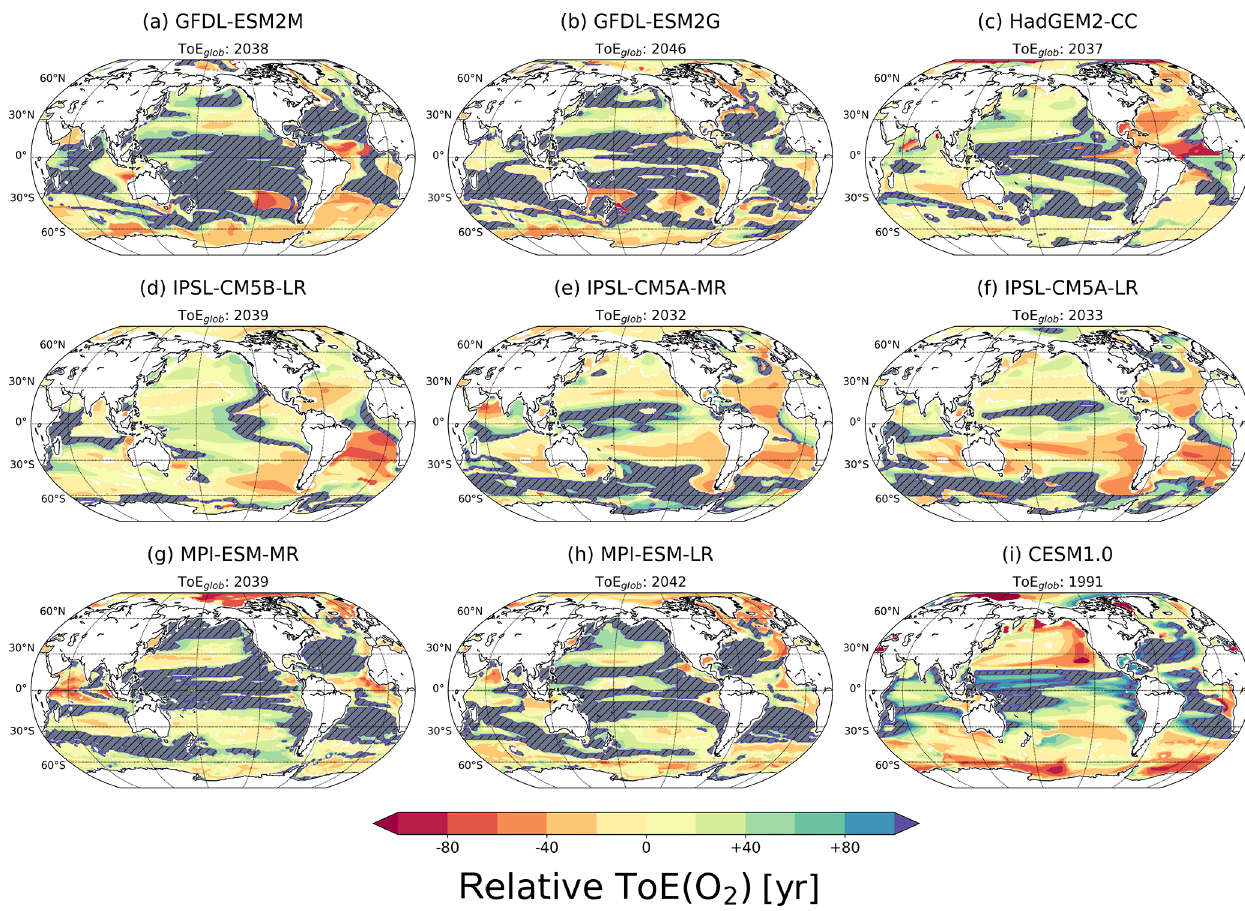
Figure 3. ToE of O 2 in the thermocline (200–600m) relative to the averaged ToE in that layer for each simulation. The hatched areas show regions with no emergence by the end of the 21st century. The absolute ToE estimates are shown in Fig. S2. The global average ToE, ToE glob , is shown for each